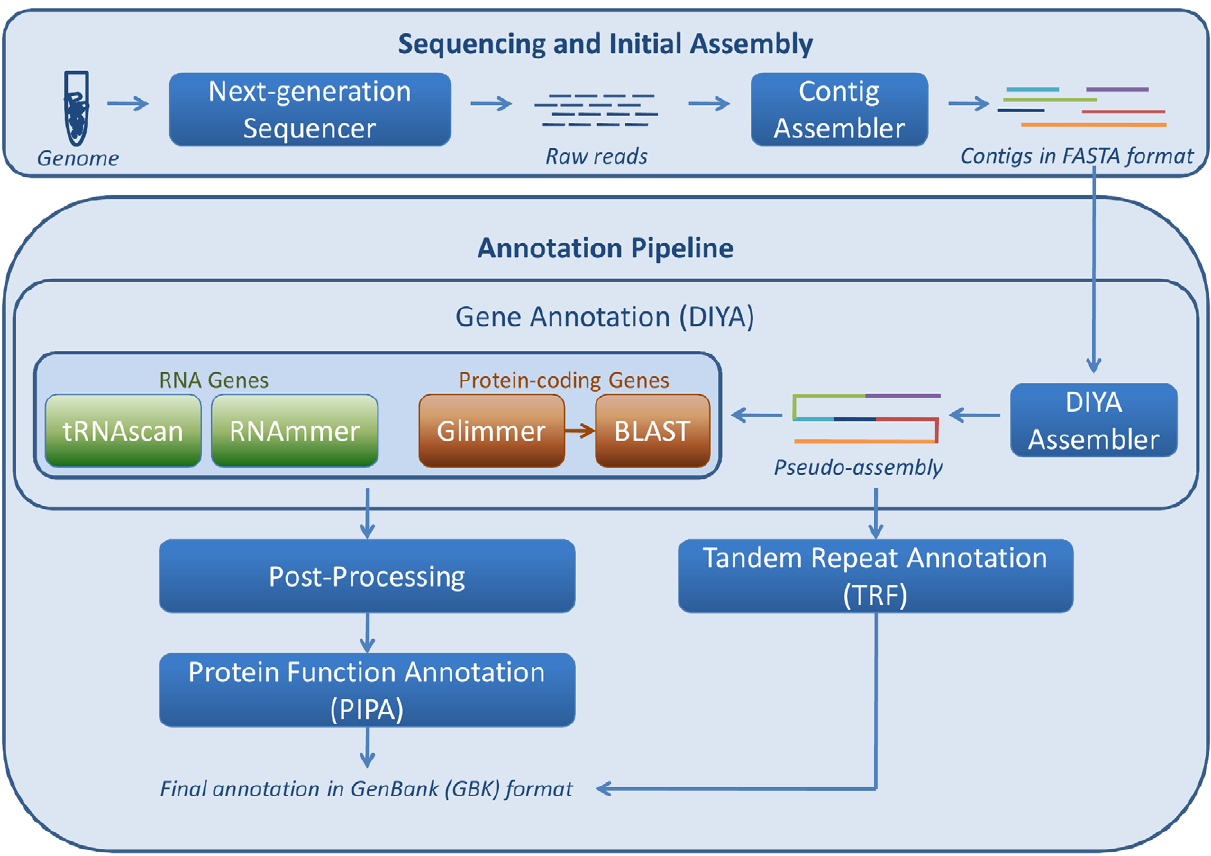
Figure 2. Schematic representation of the various tools of the genome annotation pipeline. Given assembled contigs in a FASTA format file, processing starts with the Do-It-Yourself Annotation (DIYA) genome annotation tool, followed by post-processing, tandem repeat annotation, and protein function prediction with Pipeline for Protein Annotation (PIPA).